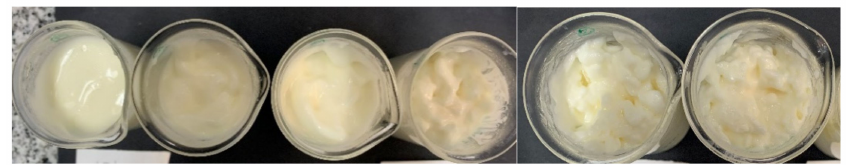
Figure 1. Stable emulsion of fresh milk containing 65%, 70%, 71%, 72%, 73% and 74% of oil (from left to right) after 6 days storage at 4 ◦